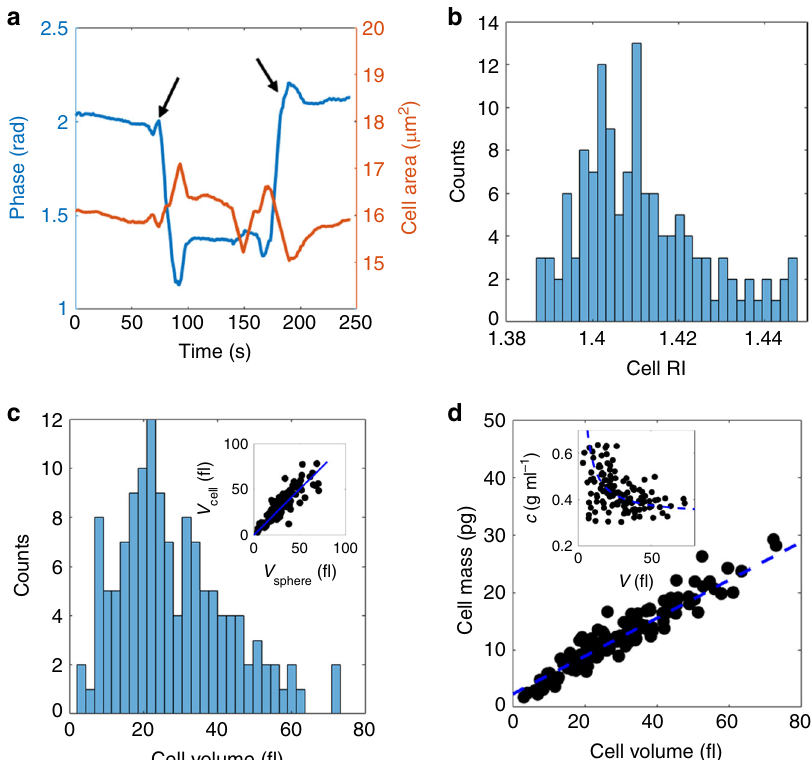
Fig. 1 Determination of cell RI and volume. a The temporal response in the average phase shift ( ^ ϕ ) (blue curve) and area (red curve) upon exposure of a yeast cell to two iso-osmotic solutes with different RI. The arrows indicate the time points of solute exchange. b , c The measured cell RIs and volumes based on the equations discussed in the main text. Inset to c shows the measured cell volume versus the expected volume for spheres of equal cross section to the imaged cells. Cells falling above the blue line are slightly prolate, cells falling below are slightly oblate. d Cell dry mass is strongly correlated with cell volume. The mass is fi tted to an expression m dry = c cyt V cyt + c p V p , with V cell = V cyt + V p , where V cyt and V p represent the osmotically active and osmotically non-responsive volumes, determined by studying the scaling of volume with external osmolarity as detailed in the text. Inset: The mass concentration is inversely related to cell volume. The blue dashed line corresponds to the same fi t as in the main fi